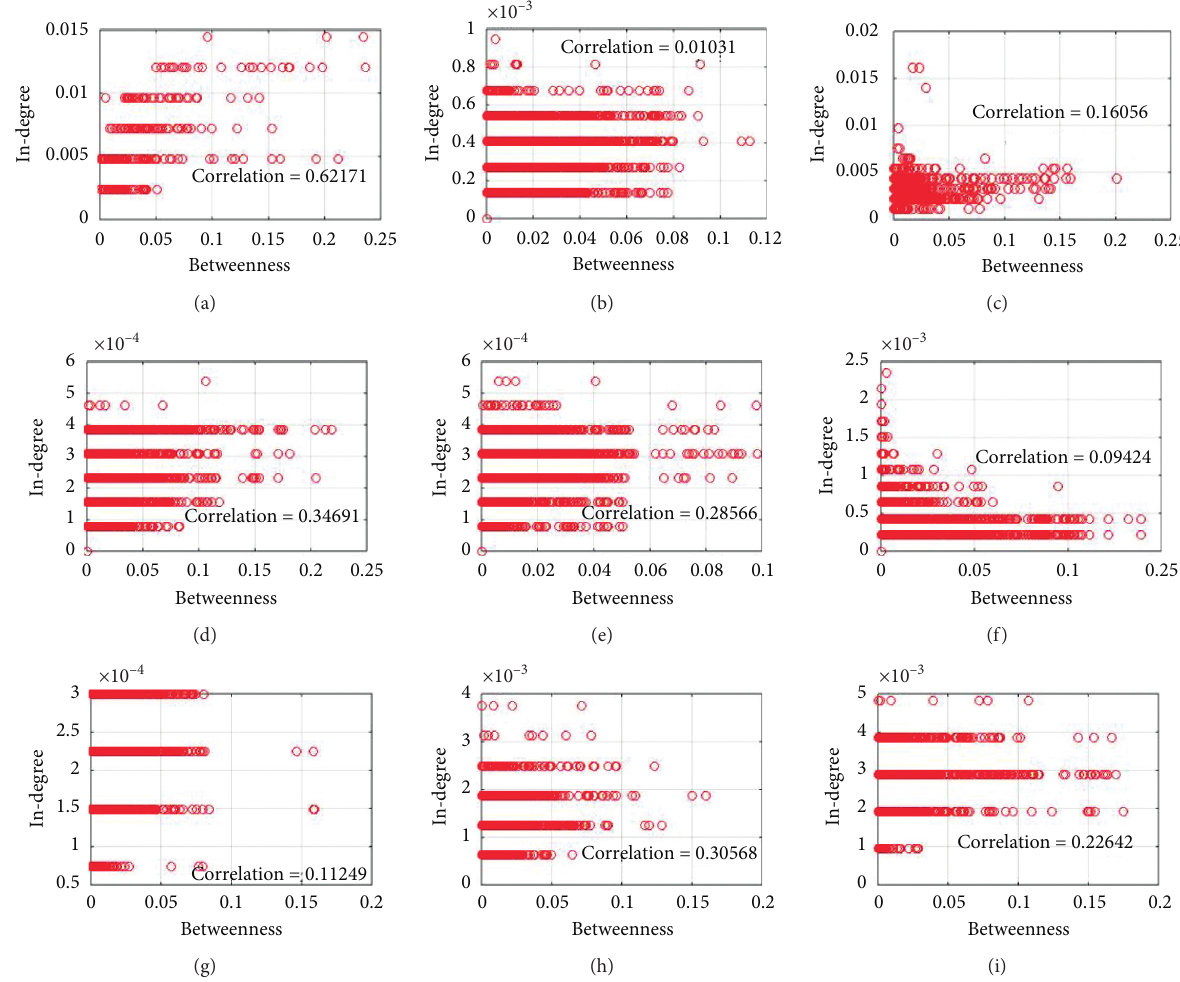
Figure 8: The correlation between normalized in-degree and betweenness: (a) Anaheim; (b) Austin; (c) Barcelona; (d) Berlin; (e) Chicago; (f) Hessen; (g) Philadelphia; (h) Terrassa; (i)